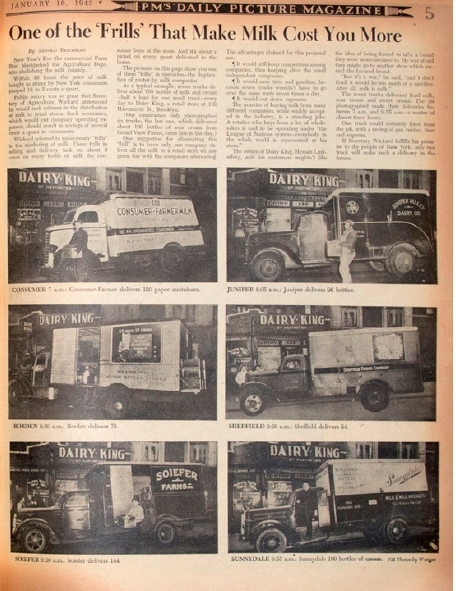
Figure 1. Arnold Beichman and Weegee. “One of the ‘Frills’ That Make Milk Cost You More”, PM , 10 January 1943. Image courtesy of the International Center of Photography.